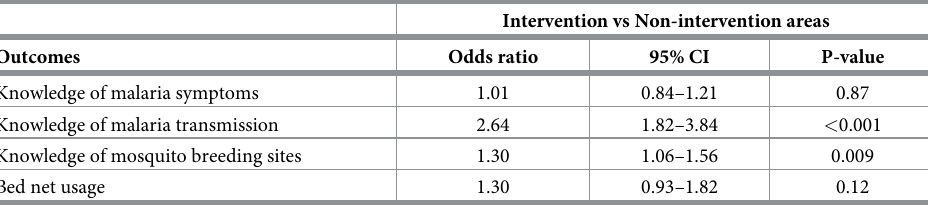
Table 5. Estimates of larviciding impact on key malaria-related knowledge and practice